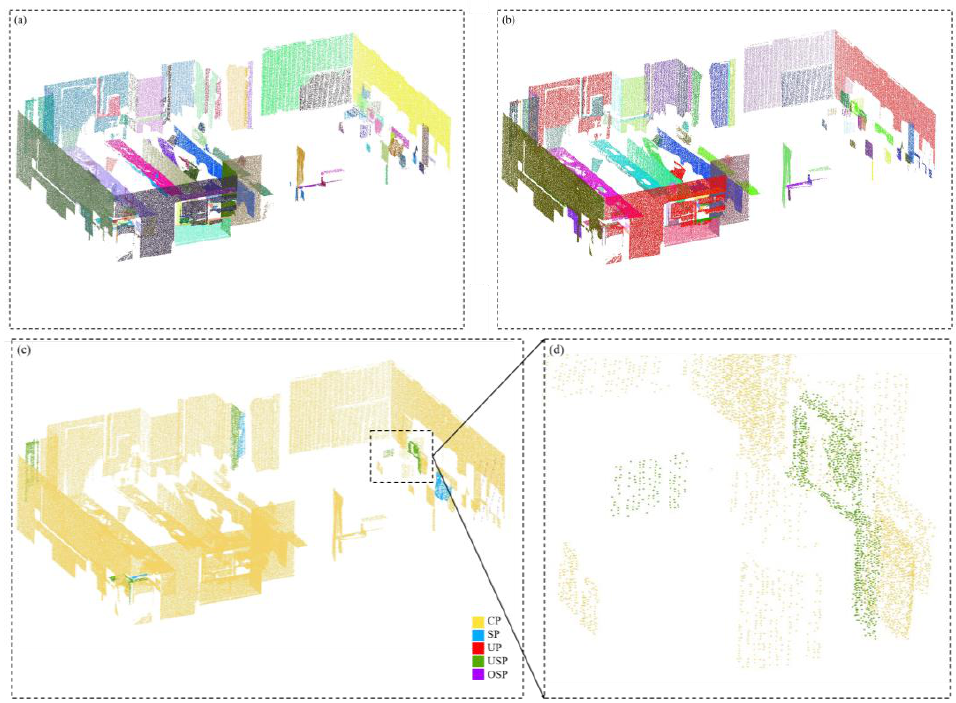
Figure 15. Plane-segmentation results for the Lab dataset: ( a ) proposed method, ( b ) ground truth, ( c ) the main differences between ( a ) and ( b ), and ( d ) enlarged part.